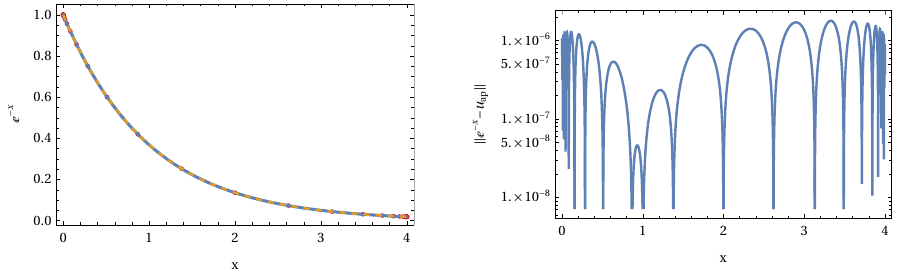
( x ) = e − x as a Sinc approximation 0,2